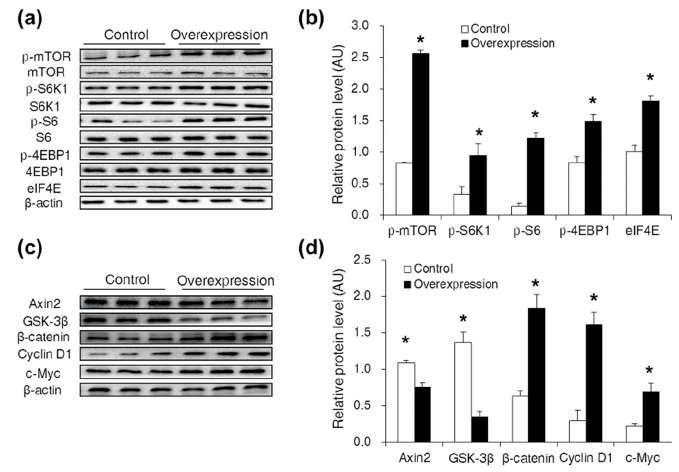
Figure 2. CDX2 overexpression activated both the mTORC1 and Wnt/ β -catenin pathways. ( a,b ) Western blot analysis of the mTORC1 pathway activity after CDX2 overexpressed in IPEC-J2 cells with quantification ( n = 3); ( c,d ) western blot of Wnt / β -catenin pathway related proteins after CDX2 overexpressed with quantification ( n = 3). AU: arbitrary unit. Control: control group; Overexpression: CDX2 overexpression group. Representative results of three independent experiments are shown. Data are expressed as the mean ± SEM; * p < 0.05.